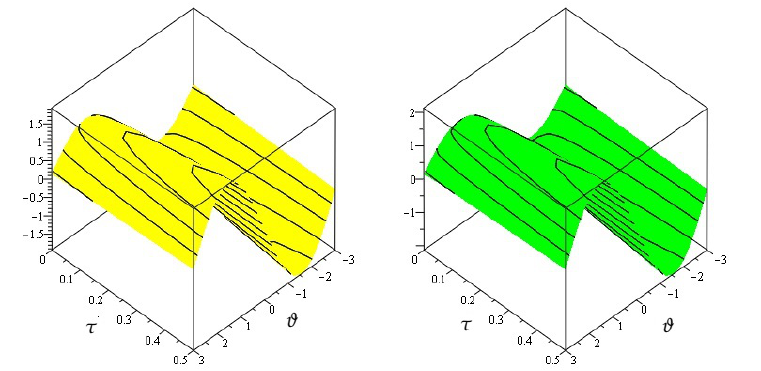
Figure 8. The analytical solutions of ν ( ϑ , ζ , z , τ ) at (cid:36) = 0.6 and 0.4 of Example